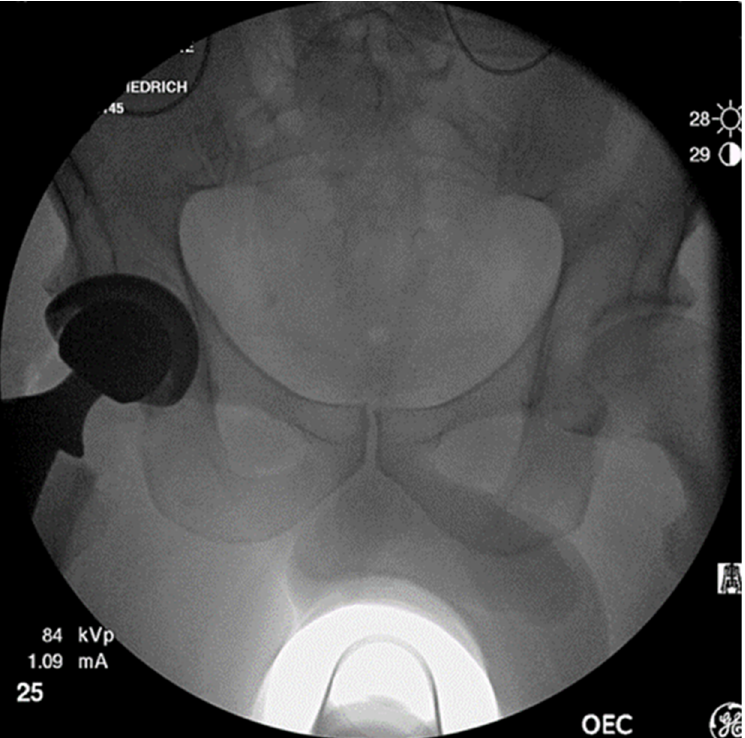
Figure 2. Intraoperative C-arm fluoroscopy image of a pelvis in antero-posterior projection after implantation of a total hip arthroplasty on the right side. The sacrum is in line with the pelvic symphysis and the obturator foramen are projected equally to avoid errors due to rotation.